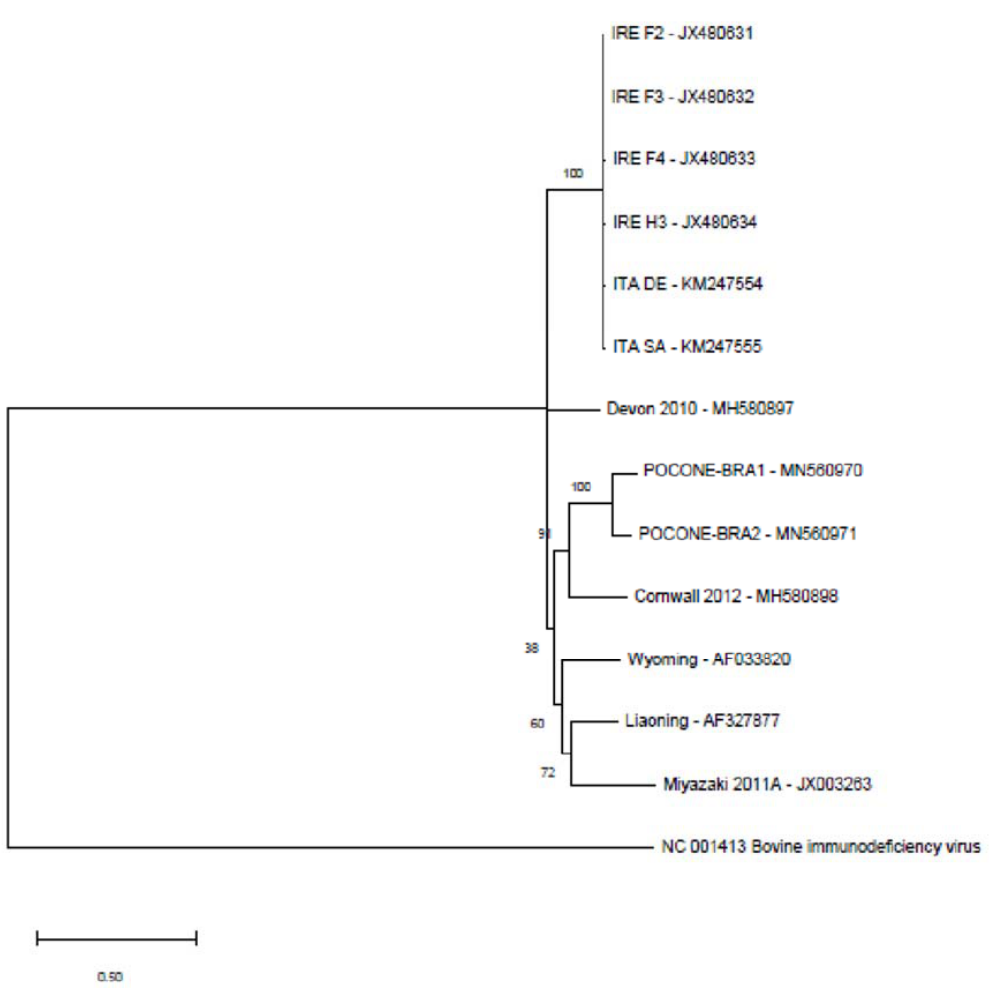
Figure 1. Cladogram involving equine infectious anemia virus (EIAV) complete genome sequences and BRA1 and BRA2 sequences obtained from the Pantanal region using the maximum-likelihood method. The following sequences were used: EIAV Miyazaki 2011A (Japan); EIAV BRA1 and EIAV BRA2 (Brazil); EIAV Liaoning (China); EIAV Wyoming (USA); EIAV ITA SA and EIAV ITA DE (Italy); EIAV IRE F2, EIAV IRE F3, EIAV IRE F4 and EIAV IRE H3 (Ireland); EIAV Cornwall 2012 and EIAV